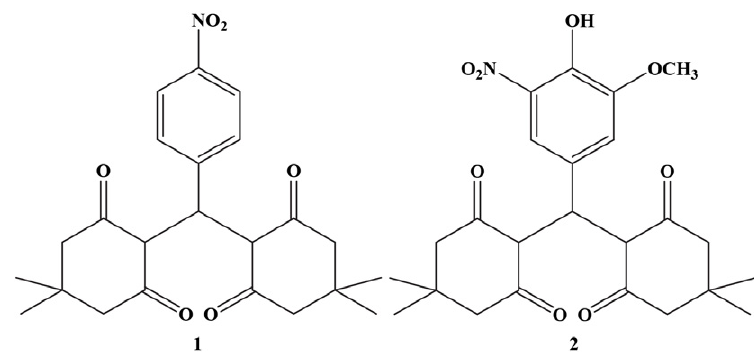
Figure 3. Structures of synthesized tetraketones 1 and 2